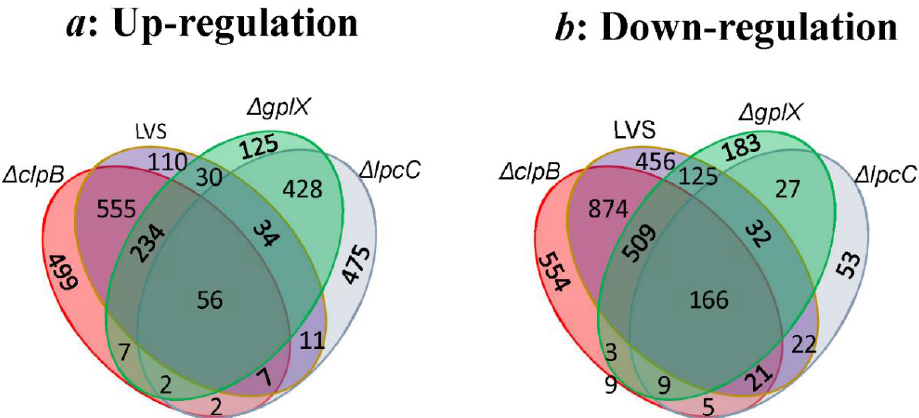
Figure 2. Numbers of differentially expressed genes in all 4 samples illustrated by Venn diagram. All up- ( a ) or down- ( b ) regulated genes, relative to spleens from naïve mice in each sample are encompassed in a colored oval. Shared genes are indicated by numbers situated on appropriate overlapping areas.